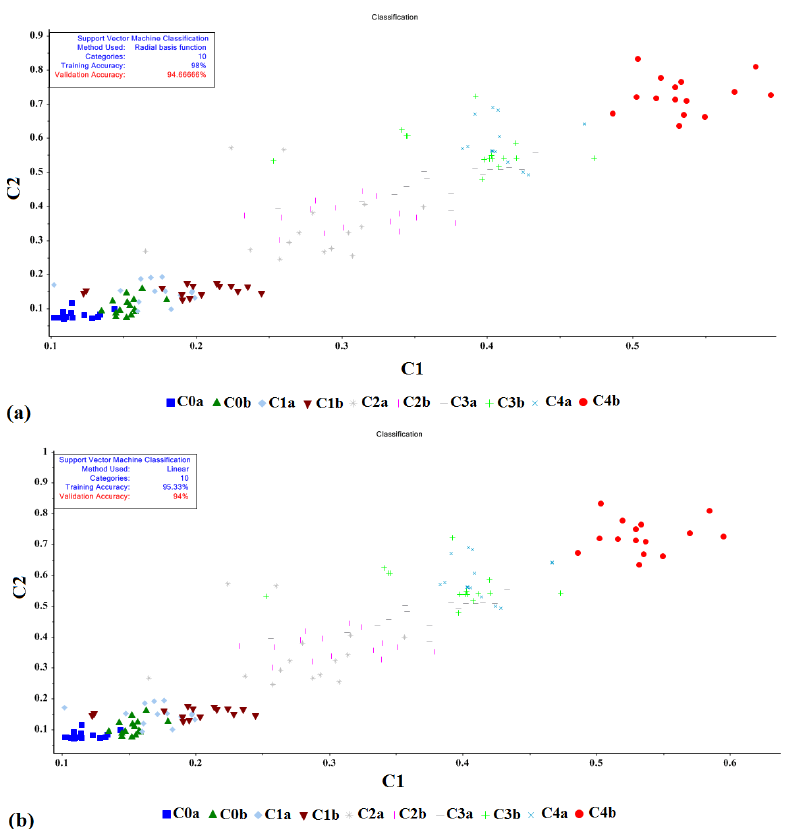
Figure 4. Classification of cucumber fruits. E-nose data using the ( a ) Nu-SVM (radial function model) and ( b ) C-SVM (linear function model) methods. Graph legend symbol combinations (for individual fruit harvests): C = cucumber fruit harvest; Numbers indicate urea fertilizer equivalent application rates: 0 = 0 kg/h, 1 = 100 kg/h, 2 = 200 kg/h, 3 = 300 kg/h, 4 = 400 kg/h; Small letters indicate sequential sub-harvests: a = first sub-harvest (4 months after planting seeds), b = second sub-harvest (5 months after planting seeds).